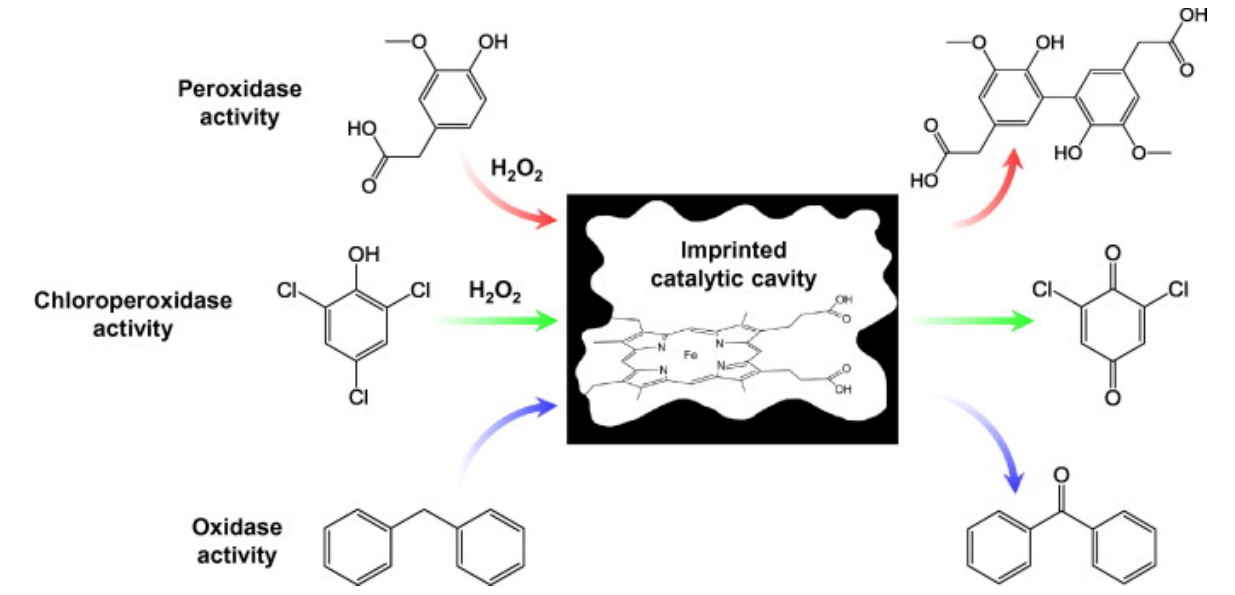
Figure 11. Catalytic activity of catalytic MIP with different substrates. with permission from [166]. Copyright 2012 Elsevier.